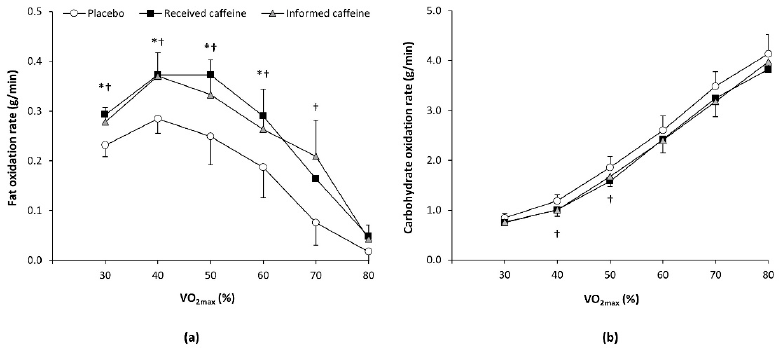
Figure 1. ( a ) Fat oxidation rate and ( b ) carbohydrate oxidation rate during an incremental step exercise test on a cycle ergometer in active individuals who ingested (1) a placebo; (2) three mg of caffeine per kg of body mass (received caffeine); and (3) a placebo, but they were told they were given three mg of caffeine per kg mass (informed caffeine). (*) Received caffeine different from placebo for the same workload at p < 0.050. ( † ) Informed caffeine different from placebo for the same workload at p < 0.050. There was a main effect of exercise intensity (F = 480.58, p < 0.001) and a substance × intensity interaction (F = 2.49, p = 0.039) in the rate of energy expenditure. However, the post-hoc analysis did not reveal any statistically significant difference in the pairwise com- parison between experimental trials at any workload. For heart rate, there was only a main effect of exercise intensity (F = 95.85, p < 0.001) with no post-hoc differences (Figure 2). Figure 2. (a) Energy expenditure rate and (b) heart rate during an incremental step exercise test on a cycle ergometer in active individuals who ingested (1) a placebo; (2) three mg of caffeine per kg of body mass (received caffeine); and (3) a placebo, but they were told they were given three mg of caffeine per kg mass (informed caffeine). There were main effects of substance (F = 5.72, p = 0.008) and exercise intensity (F = 35.95, p < 0.001) in the rating of perceived exertion during exercise, although the interac- tion between these two factors did not reach statistical significance (F = 1.56, p = 0.189). The post-hoc analysis revealed that “received caffeine” decreased the rating of perceived exertion at 30% and 40% of V(cid:4662) O 2max (all p < 0.050; Figure 3) with no other differences in the remaining workloads between experimental trials.